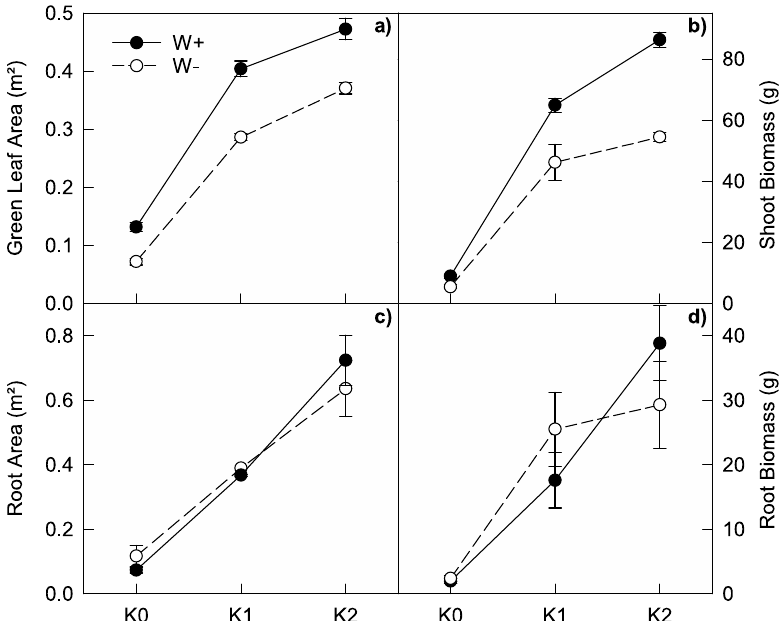
Figure 2. ( a ) Leaf area, ( b ) shoot biomass, ( c ) root area, and ( d ) root biomass of well-watered (W+, filled symbols) and water-stressed corn plants (W − , open symbols) as a function of potassium levels (K0 = low, K1 = normal, K2 = high) 29 days after the onset of the water stress (mean ± Standard Error; n = 7). Statistics are summarized in Table 1. Agriculture 2018 , 8 , x FOR PEER REVIEW